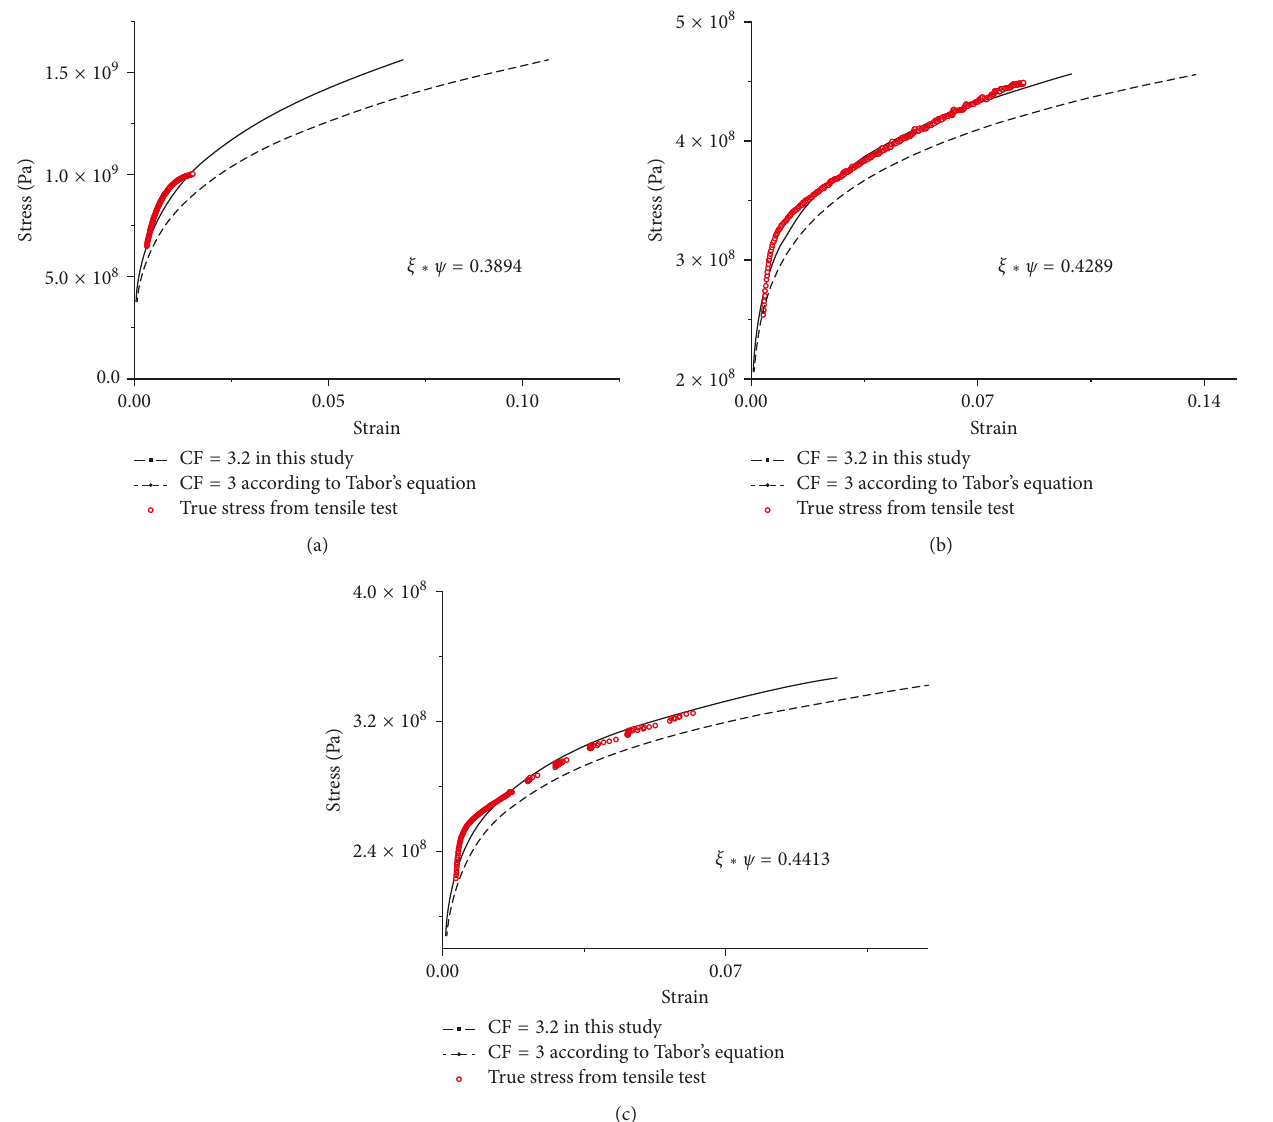
Figure 5: Curve plots for the representative stress-strain curve, Tabor’s stress-strain curve, and the true stress-strain curve extracted from the tensile test. (a) Steel, (b) brass, and (c)